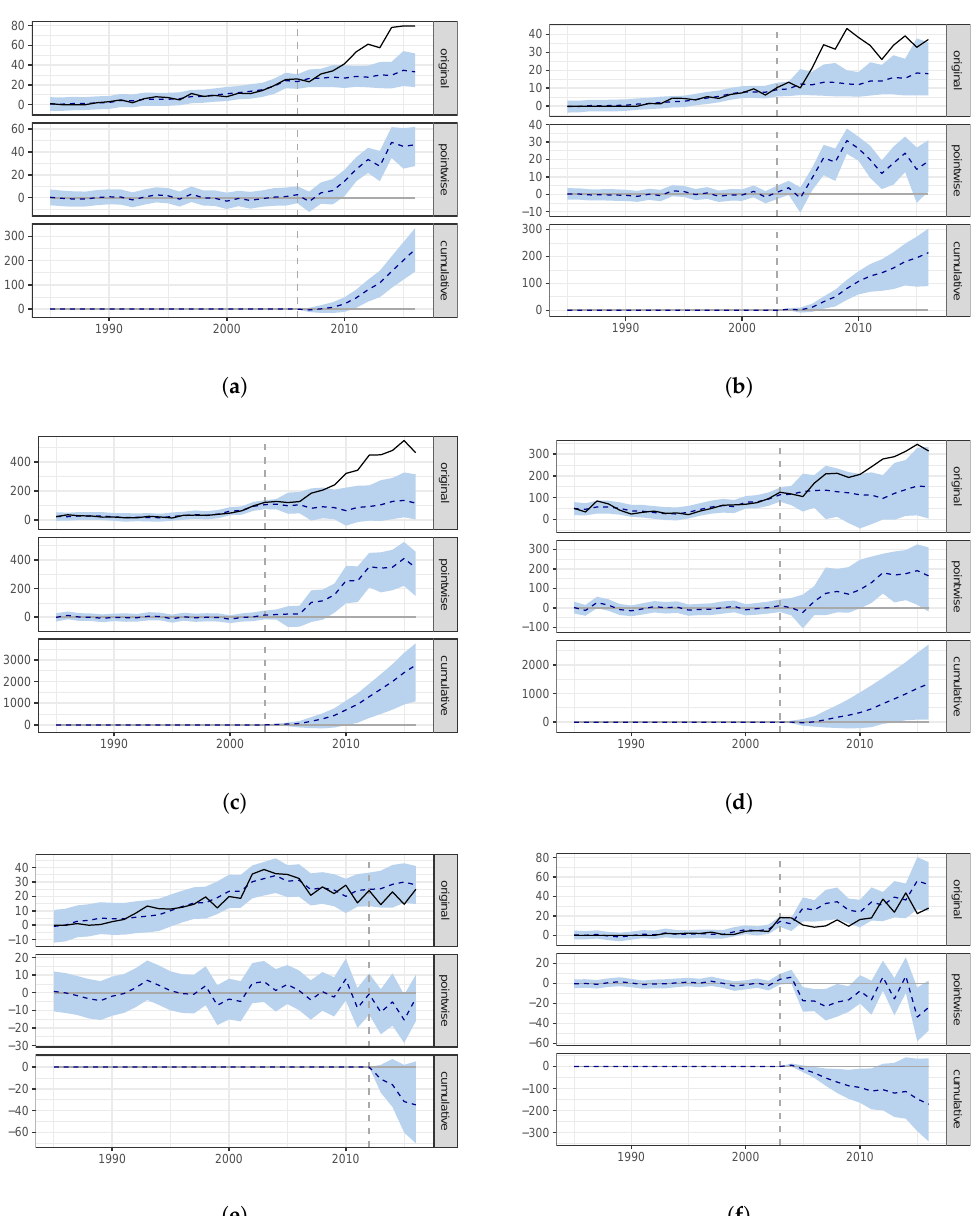
Figure 1. Significant causal impact. ( a ) Romania. ( b ) Estonia. ( c ) Poland. ( d ) Czech Republic. ( e ) Croatia. ( f )